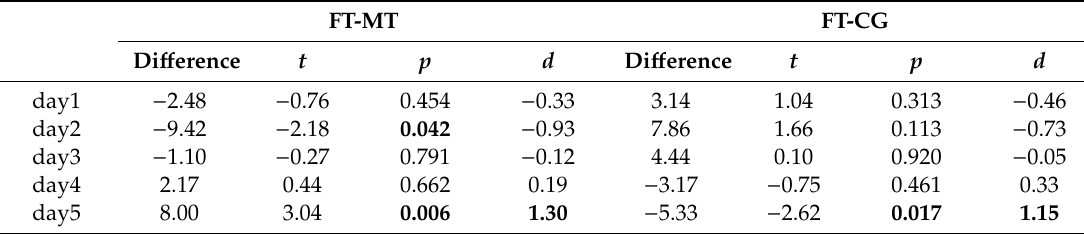
Table A2. Significance and e ff ect sizes for Deck A between the training groups.